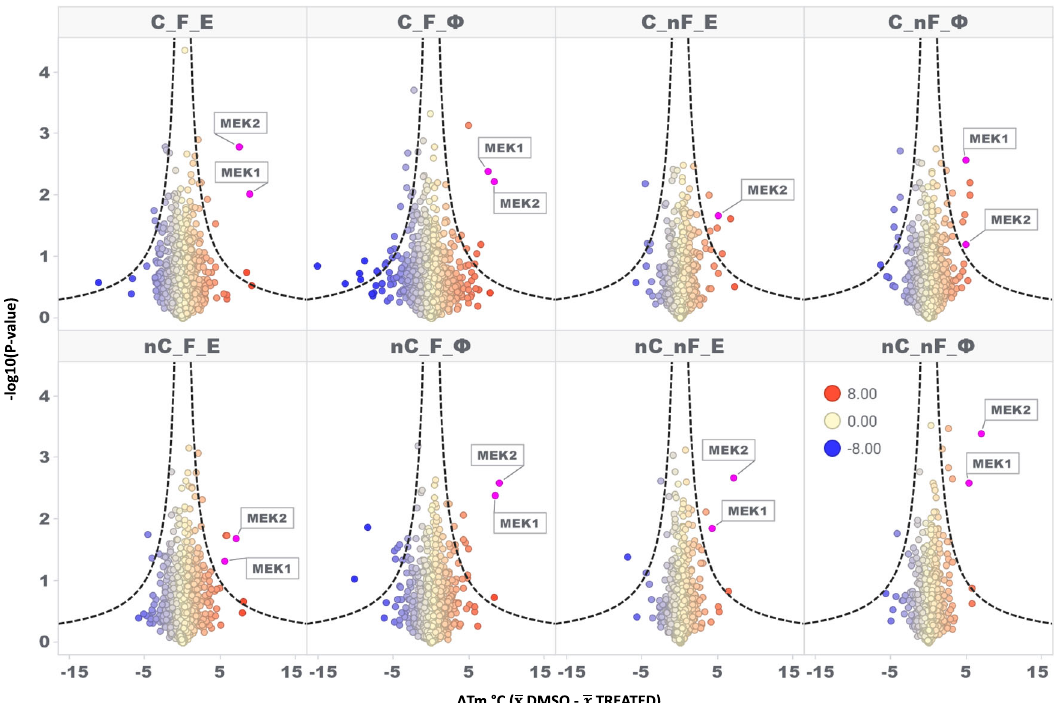
Fig. 4 High-quality melting-curves for all eight evaluated iMAATSA identi fi ed MEK targets. Volcano plots for each iMAATSA with signi fi cance cut-offs (dotted lines). MEK1 and MEK2 demonstrate signi fi cant stabilization after treatment with MEK inhibitor RO4987655. The data points represent the results of duplicate experiments.